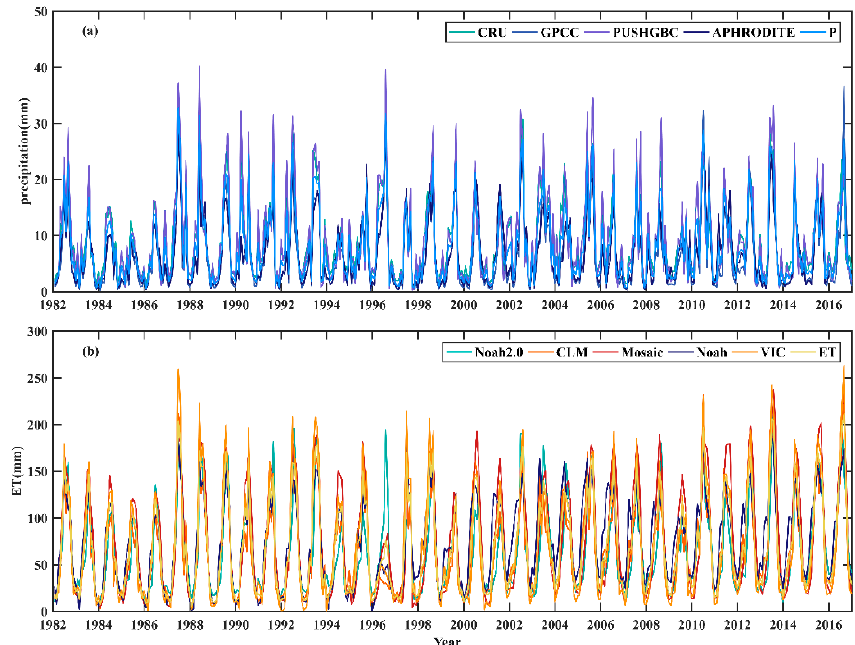
Figure 6. ( a ) Comparisons of the four precipitation datasets from APHRODITE, PUSHGBC, CRU and GPCC during the period 1982–2016 in the TRB. ( b ) As in ( a ) but for five evapotranspiration (ET) datasets.